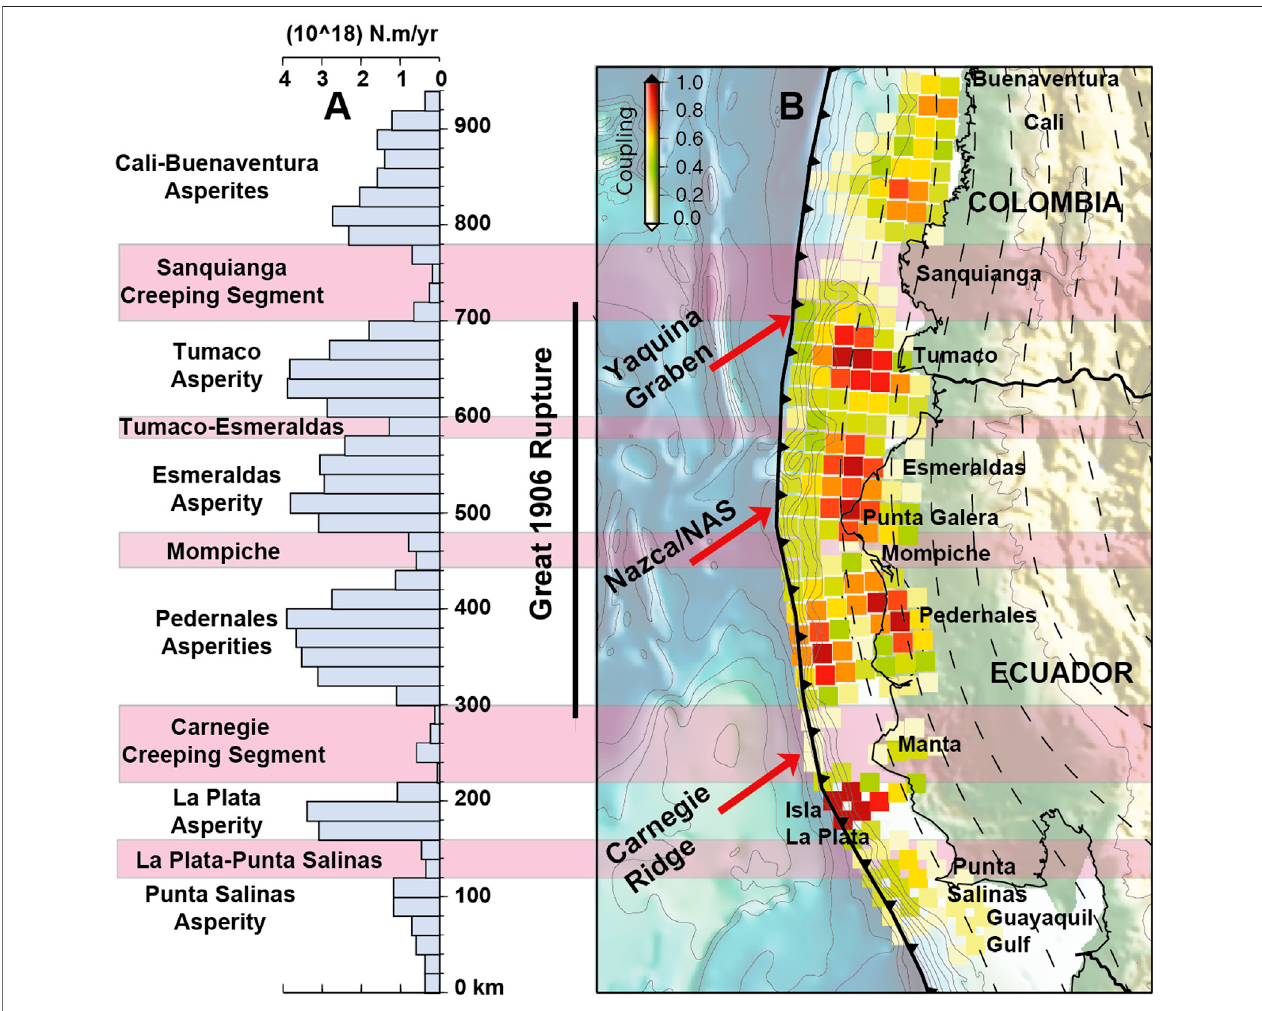
FIGURE 5 | Seismic segmentation of the Ecuador – Colombia subduction zone from the interseismic coupling map. (A) High moment de fi cit rates (in N.m/yr) indicate the location of highly locked asperities since low moment de fi cit rates highlight the presence of creeping segments. (B) Average interseismic coupling map resultingfromgeodeticinversionwitha68%con fi dencelevel.Creepingsegmentsof ∼ 80 km-widthandwithanaveragelevelofcouplinglowerthan0.2coincidewiththe entrance into the subduction of the Carnegie Ridge in Ecuador and the young oceanic crust east of the Yaquina Graben in Colombia. These two wide creeping segments have the characteristics of relatively strong seismic barriers able to stop great rupture like the great 1906 Colombia – Ecuador earthquake. Thinner creeping segments of about 20 – 40 km large appear between Tumaco and Esmeraldas and offshore Mompiche.